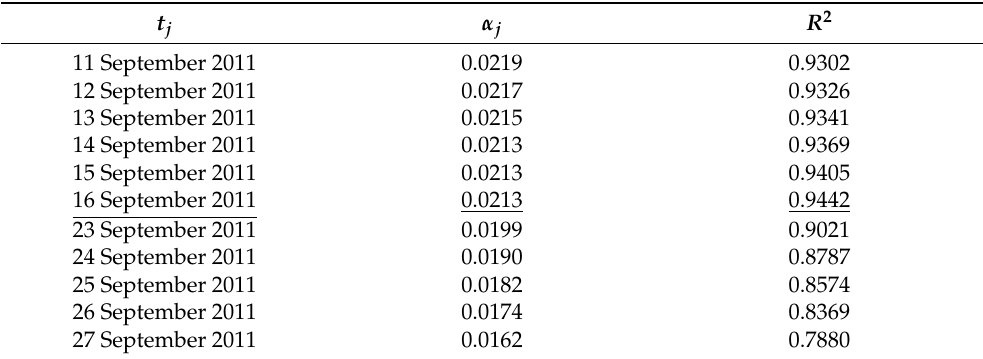
Table 2. Slopes of the segments obtained by linear regression between initial time t 0 and a neighbor- hood of M 1 with their corresponding coefficients of determination. The slope was chosen such that R 2 was the highest, as underlined. t